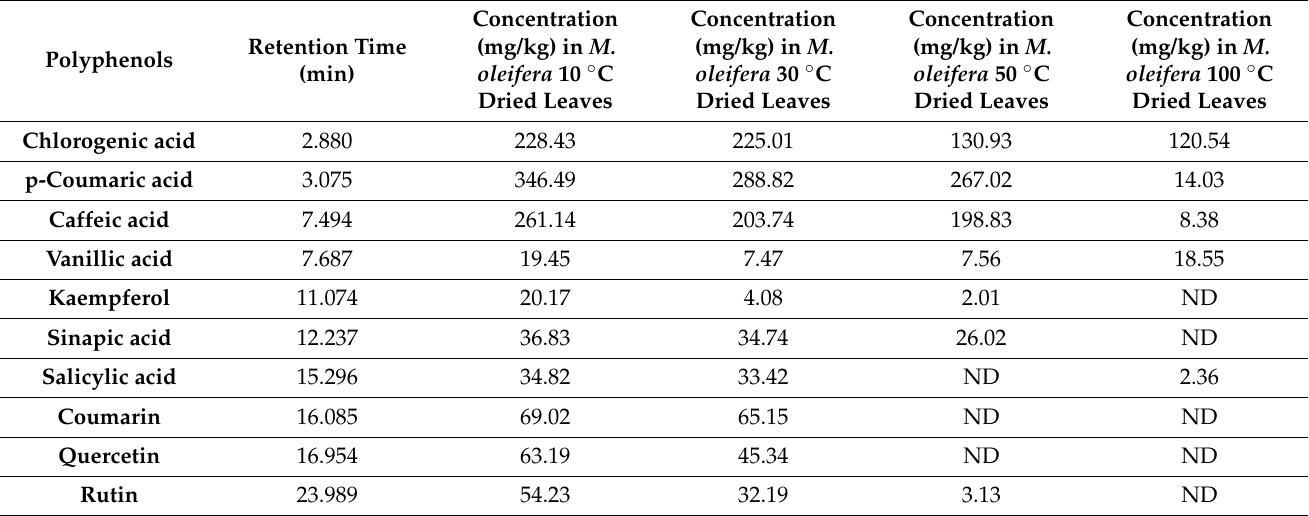
Table 1. Polyphenols identified in ethanol-based M. oleifera leaf